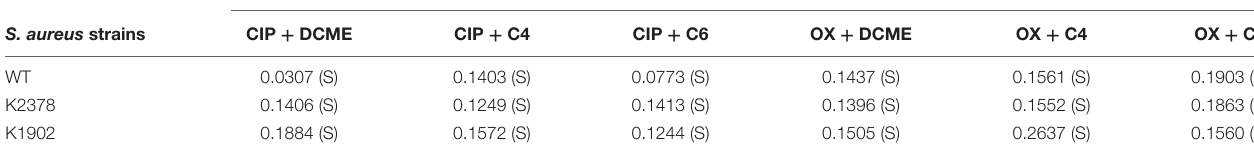
Fractional inhibitory concentration (FIC) index